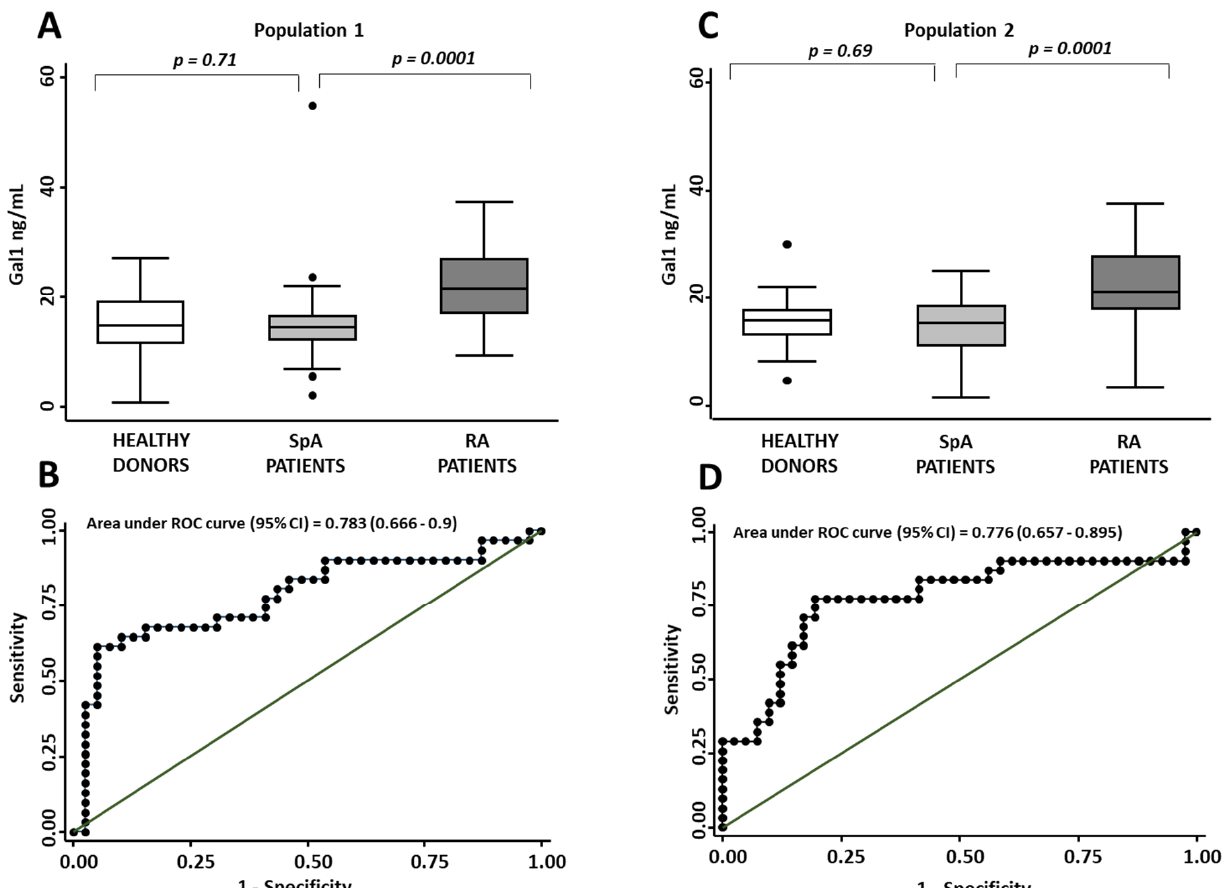
Figure 2. Spondyloarthritis patients and healthy donors show similar Gal1 serum levels and lower Gal1 serum levels than those in early rheumatoid arthritis patients. ( A , C ) determination of Gal1 serum levels with ELISA in healthy donors, spondyloarthritis (SpA) patients and early rheumatoid arthritis (RA) from populations 1 and 2, respectively. Gal1 serum levels were adjusted by age as described in the methods section. Data are shown as interquartile range (p75 upper edge of box, p25 lower edge, p50 midline) as well as p95 (line above box) and p5 (line below). Dots represent individual values. Statistical significance was determined with the Kruskal–Wallis test. Significance threshold was set at p < 0.05. ( B , D ) ROC curve analysis to assess Gal1 capacity to discriminate between SpA patients and RA patients in populations 1 and 2, respectively.